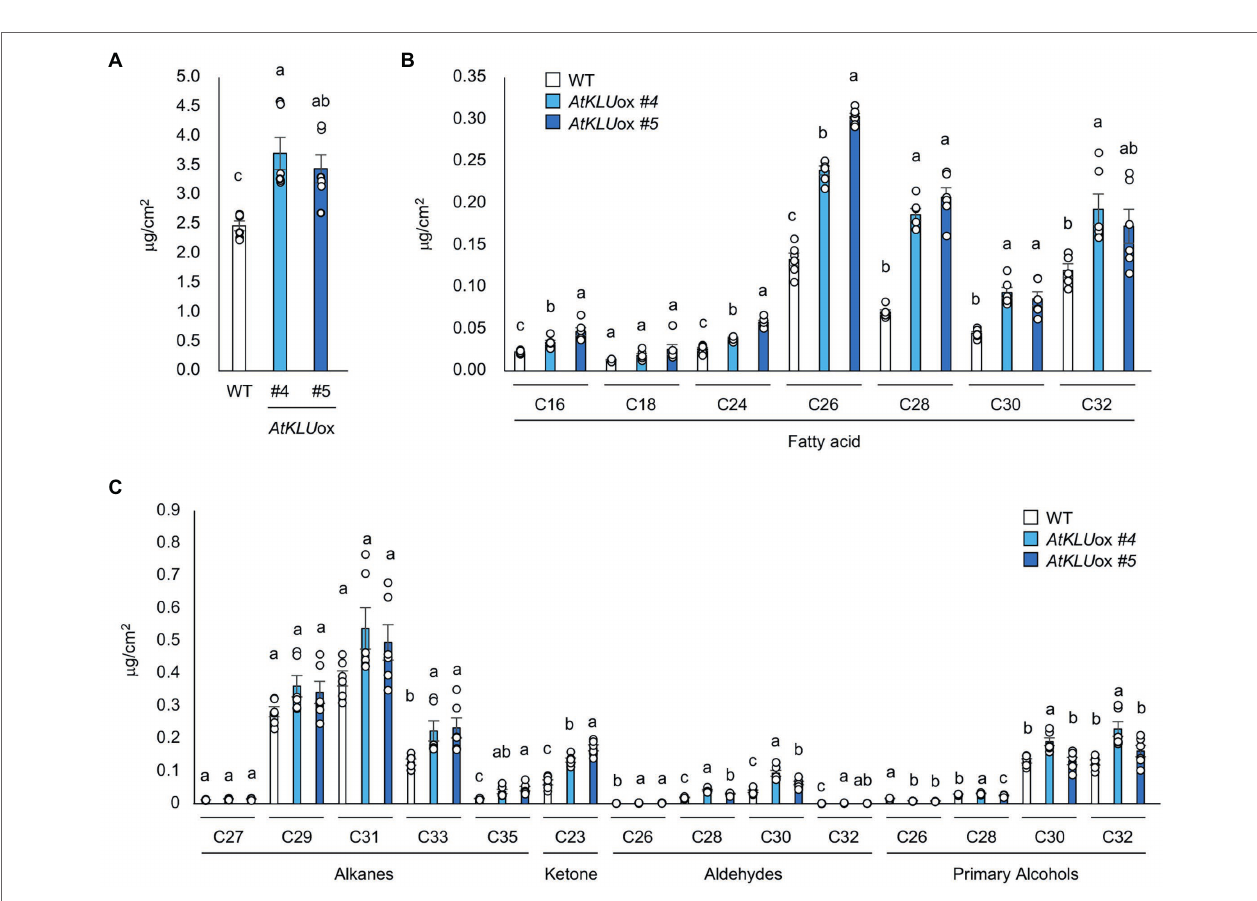
FIGURE 5 | Cuticular wax content and composition of 4-week-old WT and AtKLU ox seedlings. (A) Total wax content of WT and AtKLU ox plants. (B) Fatty acid (C16–C32) contents in WT and AtKLU ox plants. (C) Identified waxes (alkanes, ketones, aldehydes, and primary alcohols) in WT and AtKLU ox plants. Data represent means ± SE, n = 6. Within each compound type and chain length, values marked with the same letter are not significantly different based on one-way ANOVA and Tukey’s test, P < 0.05.